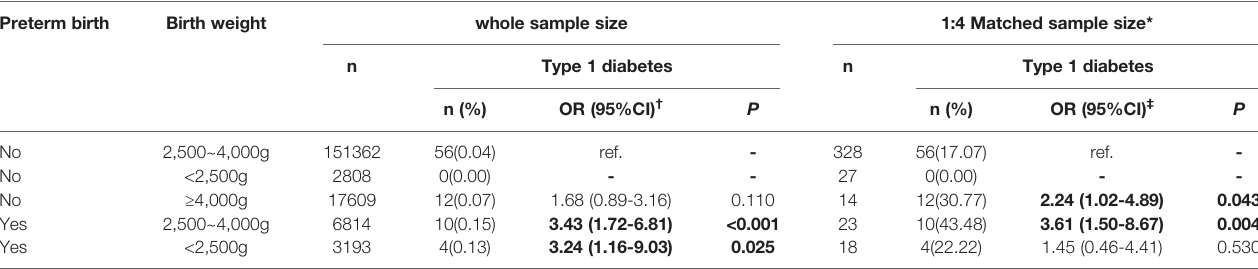
TABLE 3 | The association of birth weight and preterm birth on Type 1 diabetes in Chinese children. Preterm